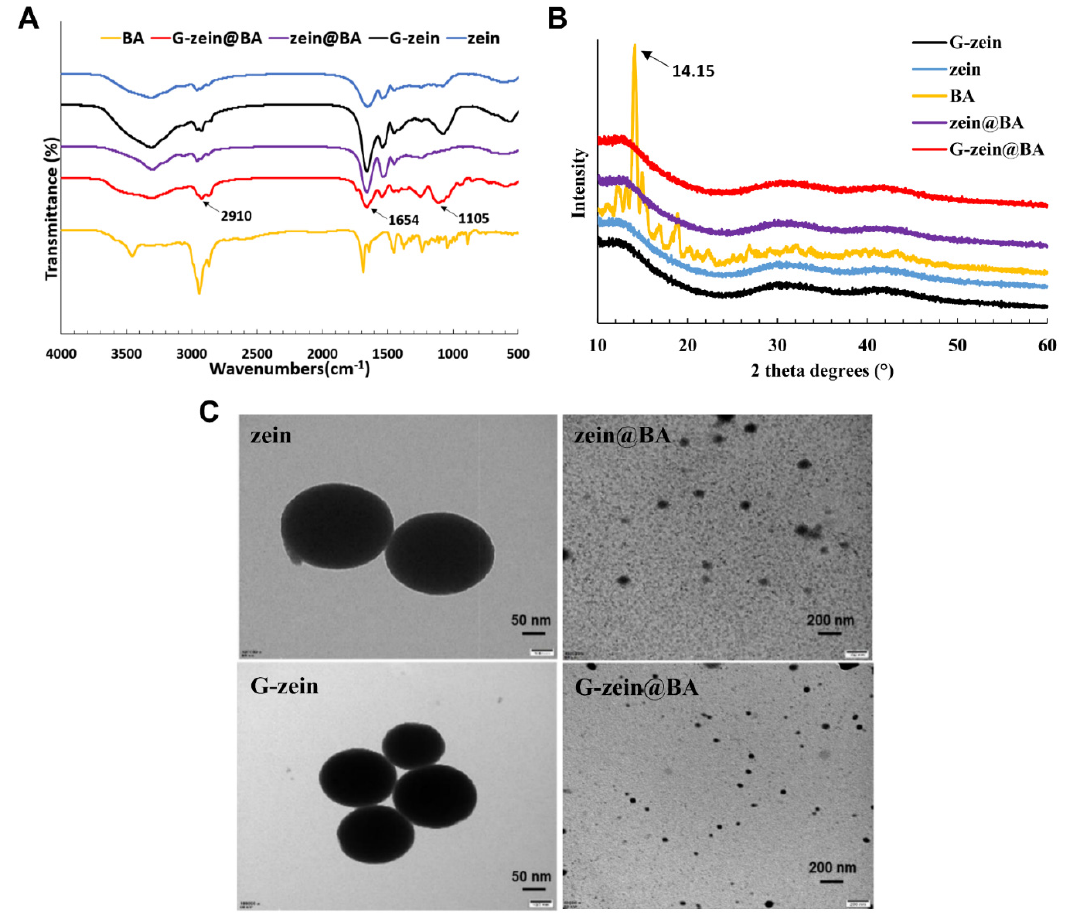
Figure 4. Spectroscopy characteristics of BA-loaded nanoparticles. ( A ) Fourier transform infrared spectroscopy and ( B ) X-ray diffraction patterns of free BA, zein, G-zein, zein@BA, and G-zein@BA. ( C ) Transmission electron microscopy images of zein, G-zein, zein@BA, and G-zein@BA.